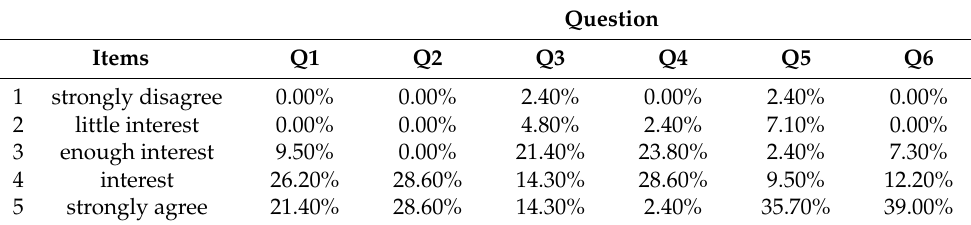
Table 9. The satisfaction level response proportion of boys >= 12 years old (secondary education).